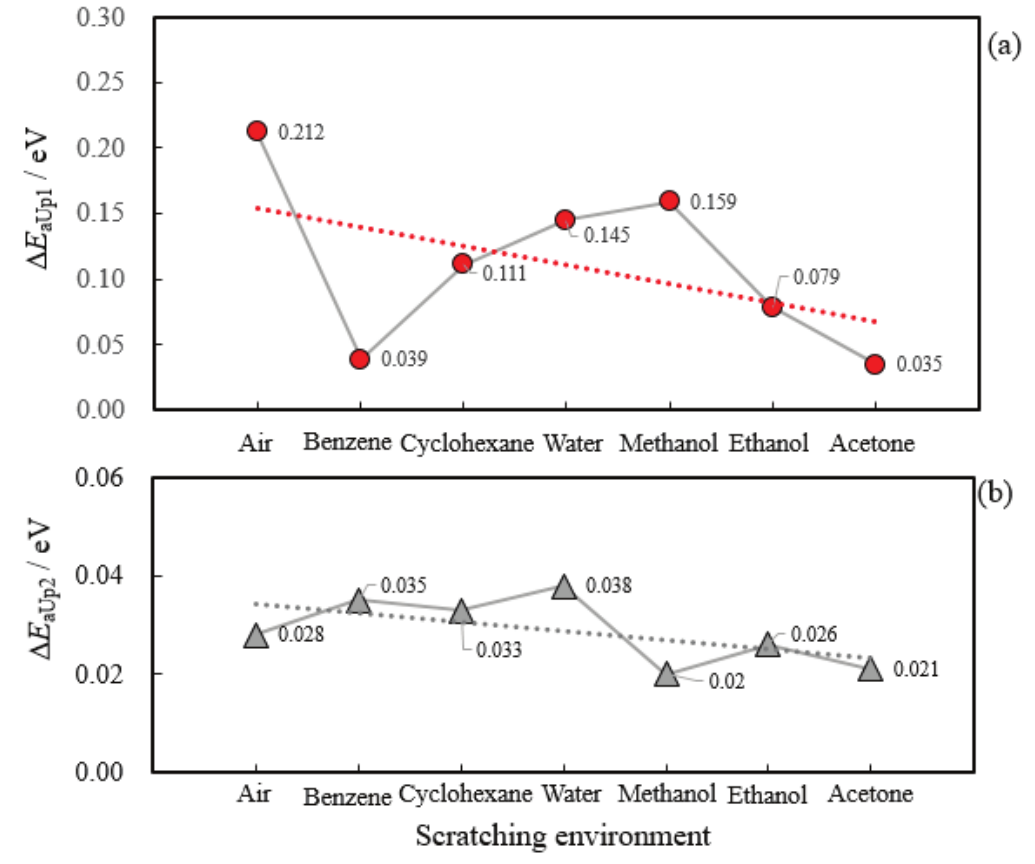
Figure 8. Plots of the activation energies of the PE quantum yields during the Up1 and Up2 temperature scans, Δ E aUp1 (a) and Δ E aUp2 (b), against the scratching environments.